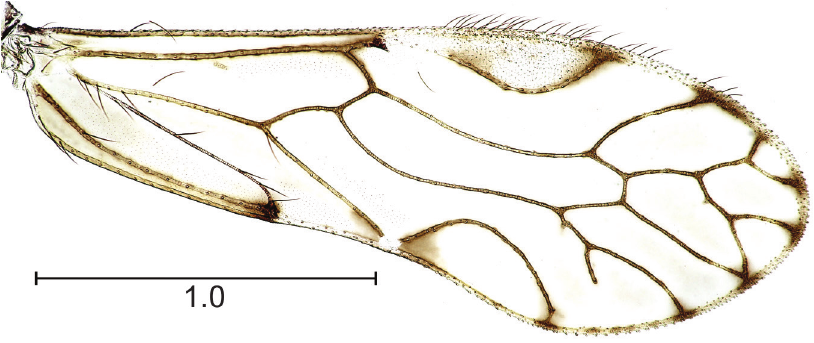
Figure 11. Anomalous forewing venation in E. saenzi sp. n. Scale in